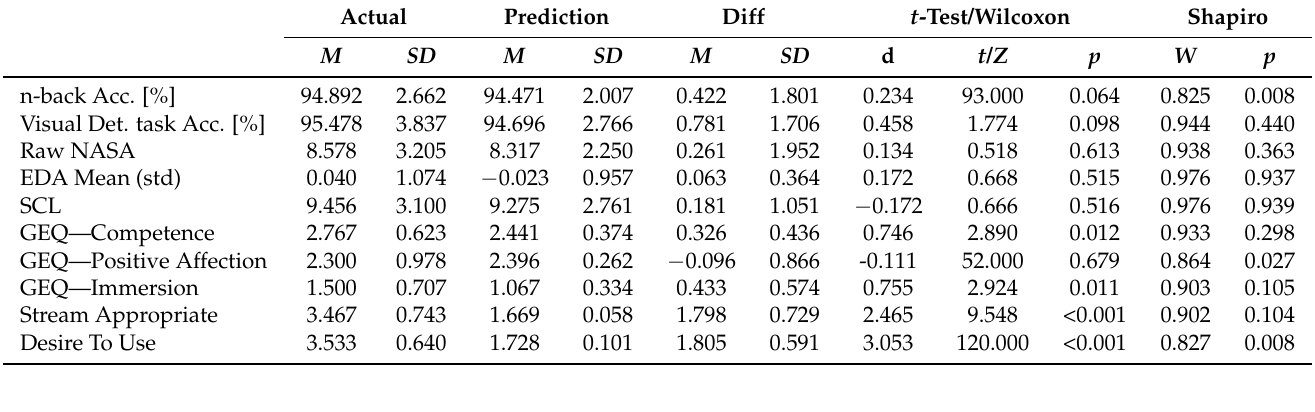
Table 2. Mean predicted and actual means across measures with Welsh-corrected t -test or Wilcoxon- signed-rank test depending on the Shapiro test and Cohen’s d. We compare the predicted value from the LMM at an optimized Stream with the actual value at this rate of Stream.